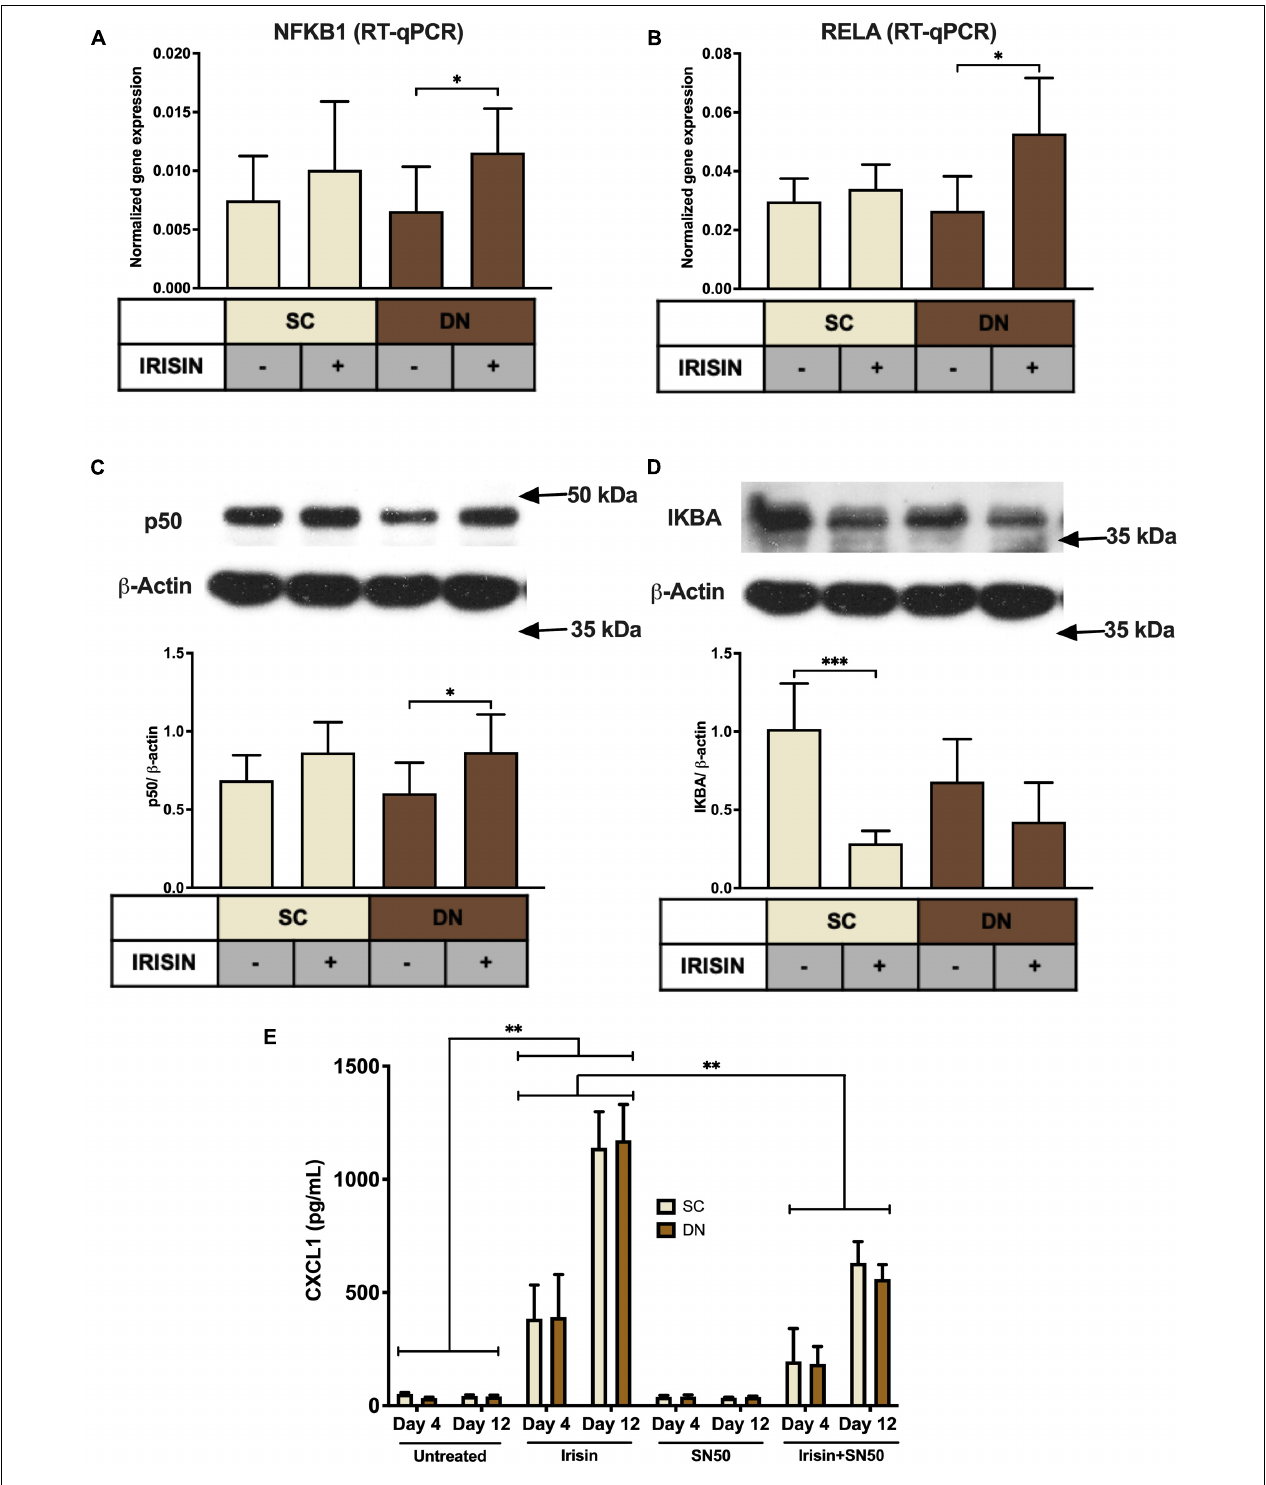
FIGURE 5 | CXCL1 release is stimulated via the NF κ B pathway during the differentiation of subcutaneous (SC) and deep-neck (DN) area adipocytes. SC and DN preadipocytes were differentiated and treated as in Figures 1–4 . Quantification of gene expression for NFKB1 (A) and RELA (B) , normalized to GAPDH by RT-qPCR ( n = 5), (C) p50 and IKBA (D) protein expression, normalized to β -actin ( n = 6), (E) CXCL1 release from differentiating adipocytes with or without irisin treatment, in the presence or absence of 50 µ g/ml SN50 ( n = 4); comparisons are for the respective days. Data presented as Mean ± SD. ∗ p < 0.05, ∗∗ p < 0.01, and ∗∗∗ p < 0.001. Statistics: One-way ANOVA with Tukey’s post-test (A–D) and Two-way ANOVA with Tukey’s post-test (E) .